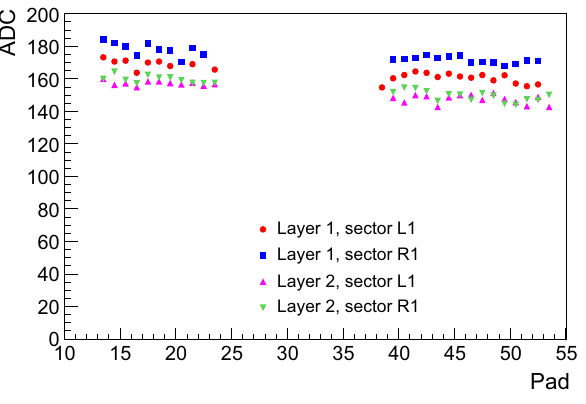
Fig. 11 Signaltonoiseratioforthepadsofthetrackinglayerscovered by the electron beam of 5